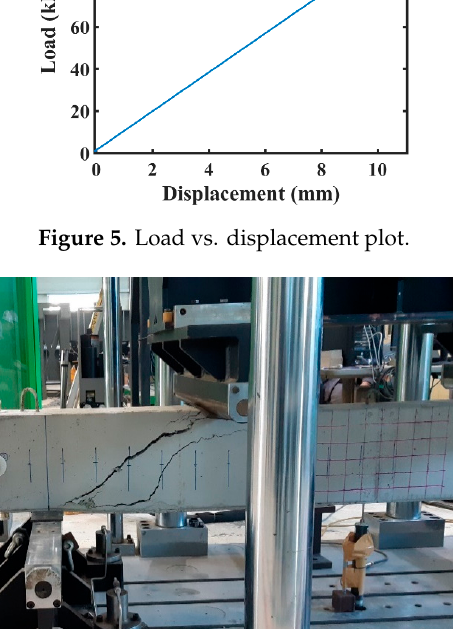
Figure 5. Load vs. displacement plot.